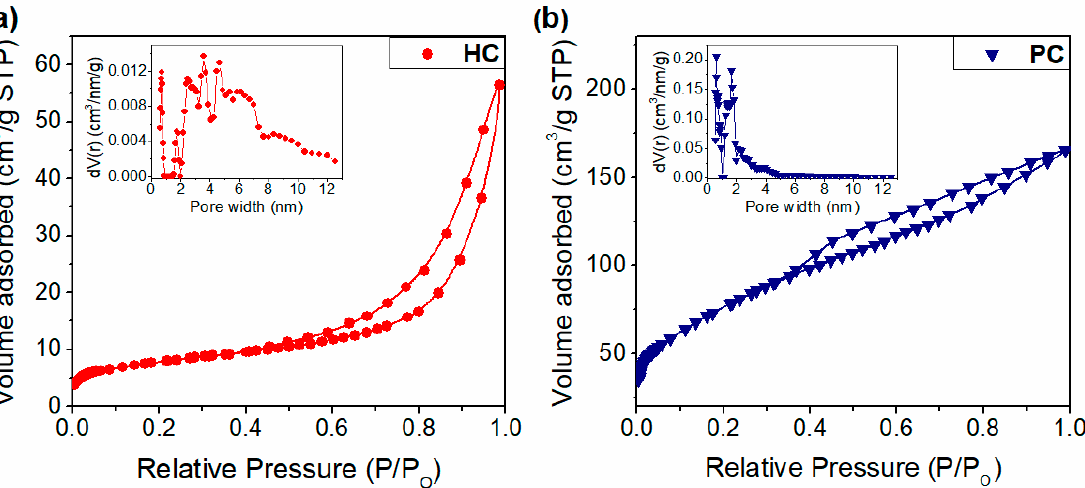
Figure 1. N 2 adsorption–desorption isotherms and DFT pore size distribution (insert) for ( a ) HC and ( b ) PC.